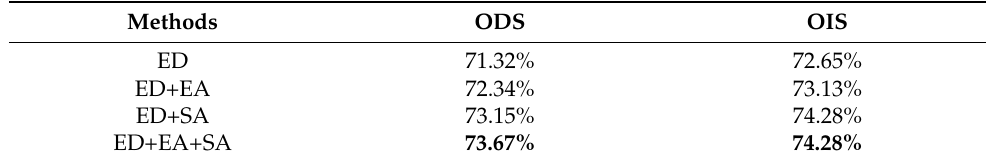
Table 1. Accuracy comparison among the methods with different modules.